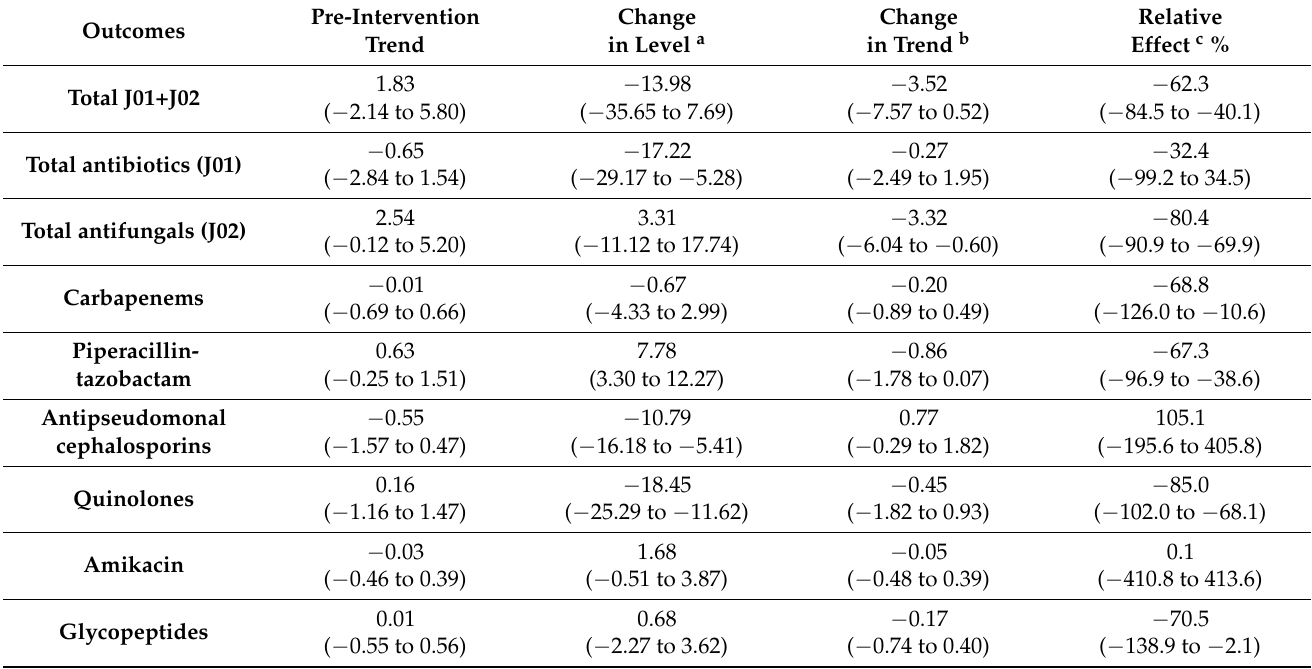
Table 1. Interrupted time-series analysis of changes in trends of antimicrobial consumption.